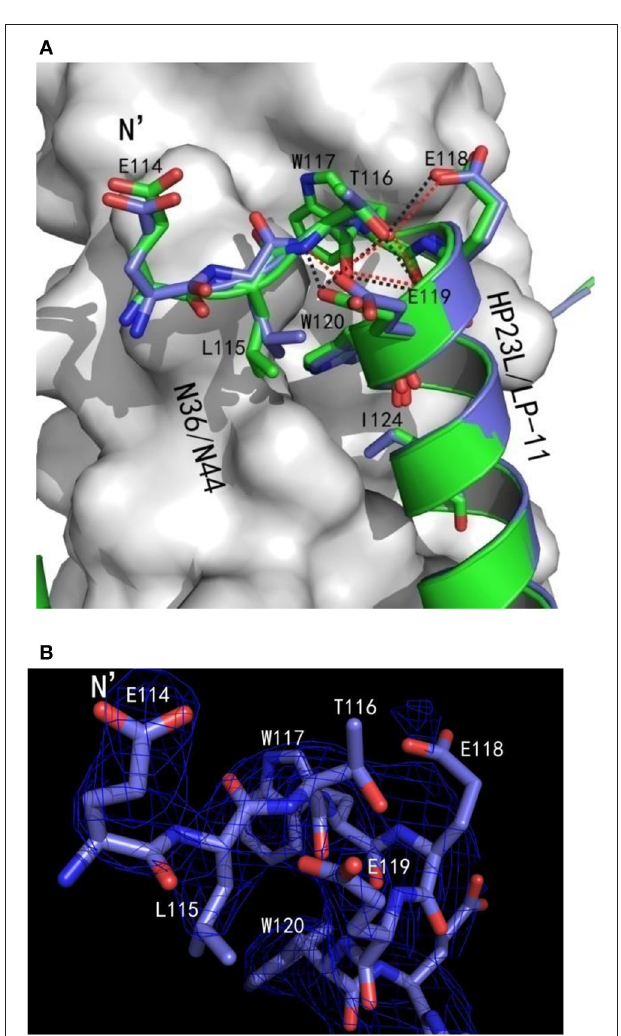
FIGURE 6 | hydrogen bonds between HP23L and N36 are indicated with dashed black lines. Salt-bridges and hydrogen bonds between LP-11 and LP-11 are indicated with dashed red lines.